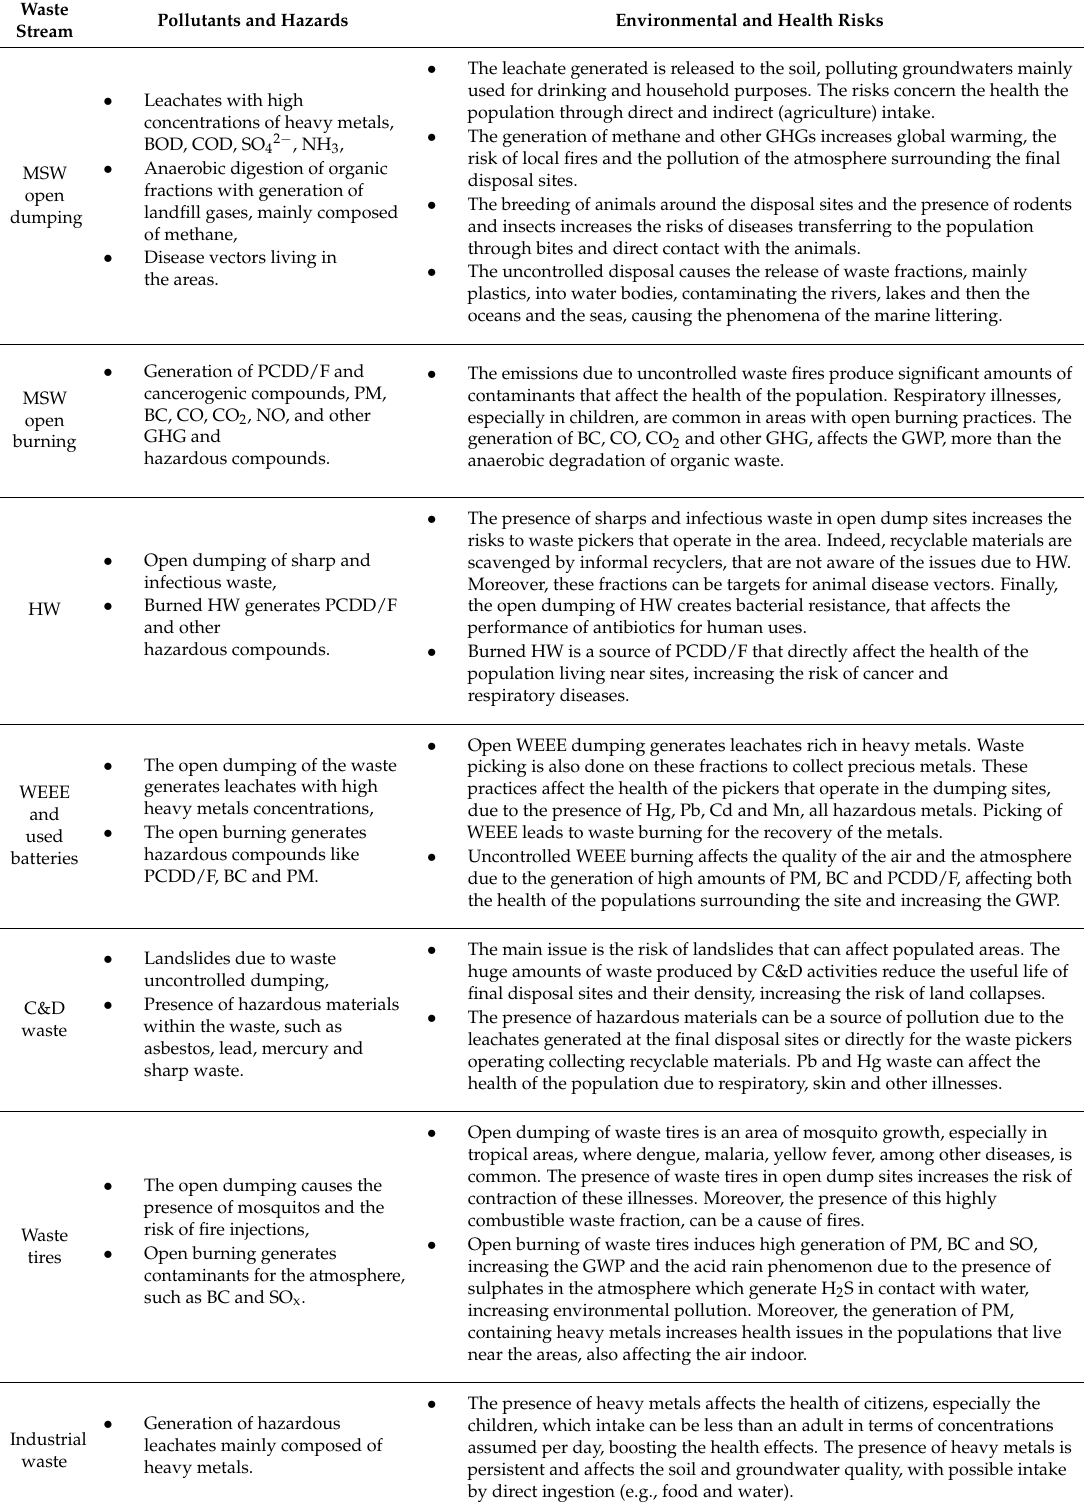
Table 4. Environmental and health risks due to waste open burning and open dumping for different waste